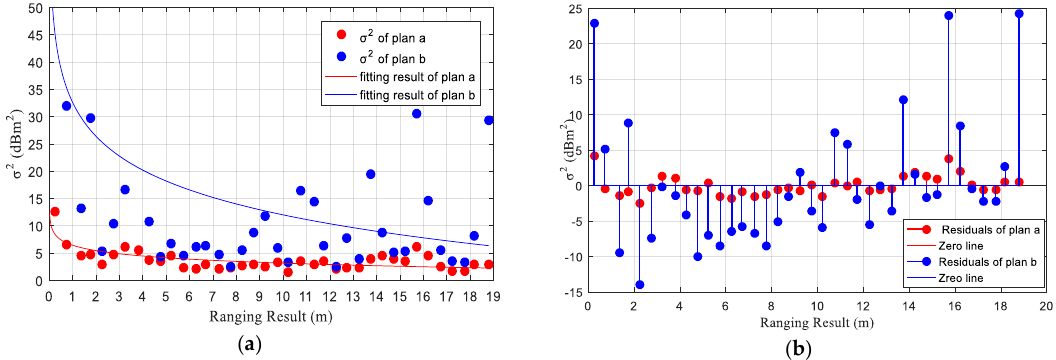
Figure 8. Fitting results of the two methods. ( a ) Fitting result and the raw data of methods A and B. ( b ) Residuals of the fitting plans of methods A and B.